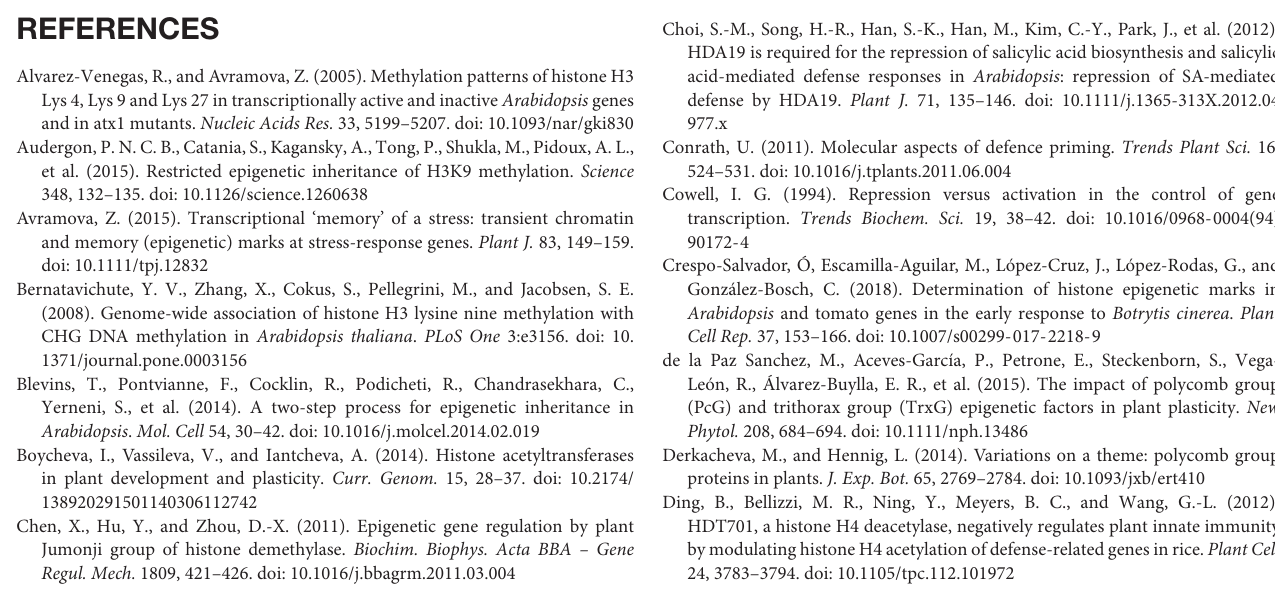
FIGURE S3 | Transcript levels of genes modifying histone methylation – TrxG (A) , SUVH4 (B) , and demethylation JMJ706 (C) in primed potato progeny derived